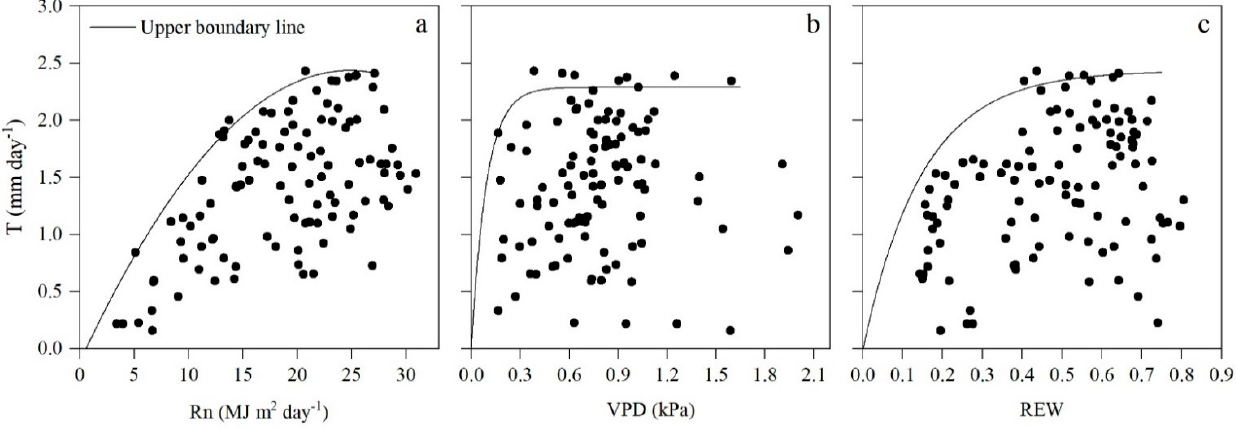
Figure 4. Response of the daily T of the white birch stand to the varying Rn ( a ), VPD ( b ), and REW ( c ) during odd days in 2017, 2021 (May–September).